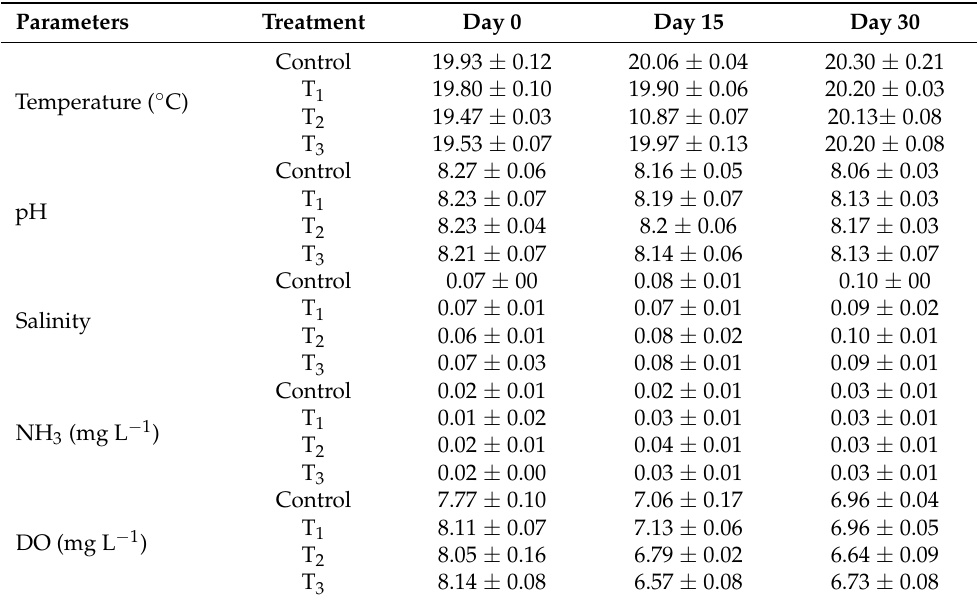
Table 3. Physicochemical properties of water in different treatment groups.